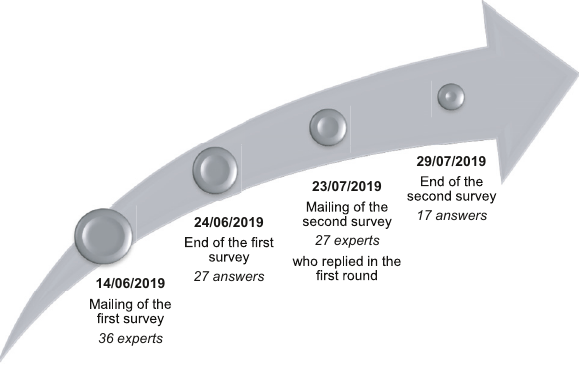
Figure 1: The chronology of the